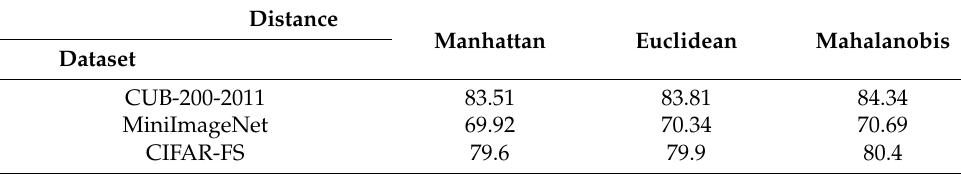
Table 1. Different measurement